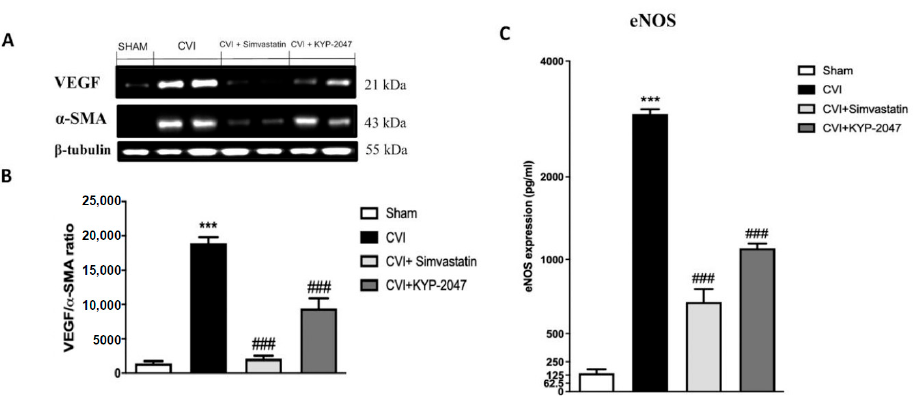
Figure 3. KYP-2047 treatment on VEGF/ α -SMA expression and eNOS levels. VEGF/ α -SMA ratio expression was analyzed by Western blot, suggesting an increment of this marker in CVI group, compared to control animals ( A ), see the densitometric units score ( B ); treatment with KYP-2047 significantly reduced VEGF/ α -SMA expression ( A ), see the densitometric units score ( B ). ELISA kit for eNOS expression on saphene vein samples was performed; treatment with KYP-2047 (10 mg/kg, i.p.) significantly reduced IL-8 quantification ( C ), compared to the high amount of eNOS released in the CVI-damaged groups ( C ). Data represent the means of at least three independent experiments. One-way ANOVA followed by Bonferroni post-hoc. *** p < 0.001 versus Sham; ### p < 0.001 versus CVI.